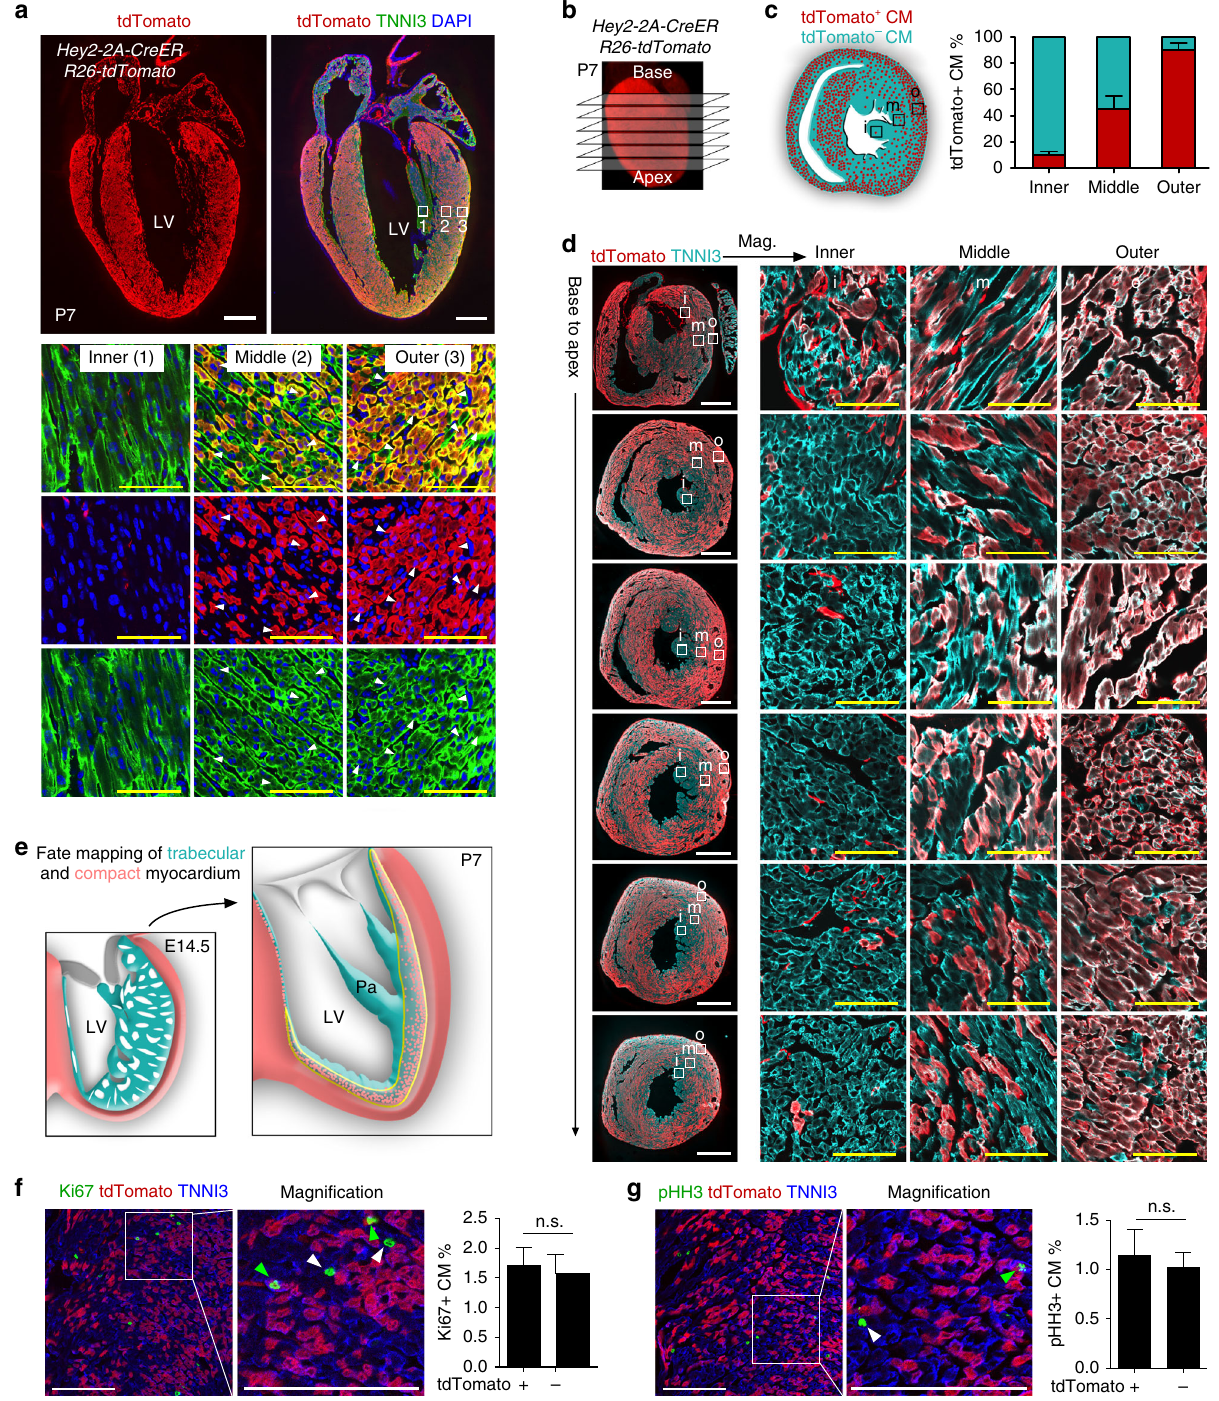
Fig. 5 Fetal compact myocardium expands into pre-existing trabecular layer to form hybrid myocardial zone. a Immunostaining for tdTomato and TNNI3 on P7 Hey2-2A-CreER;R26-tdTomato heart sections. The boxed regions in the inner, middle, and outer myocardial wall are magni fi ed. Tamoxifen was induced at E12.5. b Transverse sections of P7 heart from base to apex. c Quanti fi cation of the percentage of tdTomato + cardiomyocytes (CM) in the inner, middle and outer myocardial wall. n = 4. d Immunostaining for tdTomato and TNNI3 on transverse sections shows different contribution of tdTomato + CMs in the inner i, middle m, and outer o myocardial wall. e Cartoon fi gure showing the fate mapping of embryonic trabecular and compact myocardium into the postnatal stage. Yellow lines encircles hybrid myocardium. LV left ventricle, Pa papillary muscle. f , g Immunostaining for tdTomato, TNNI3, and Ki67 ( f ) or pHH3 ( g ) on P7 Hey2-2A-Cre;R26-tdTomato heart sections. Quanti fi cation of the percentage of proliferating cardiomyocytes (CM) in tdTomato + or tdTomato − populations. n.s . non-signi fi cant; n = 4. Scale bars, 500 µ m ( white ) in a , d ; 100 µ m ( yellow ) in a , d ; 100 µ m in f ,